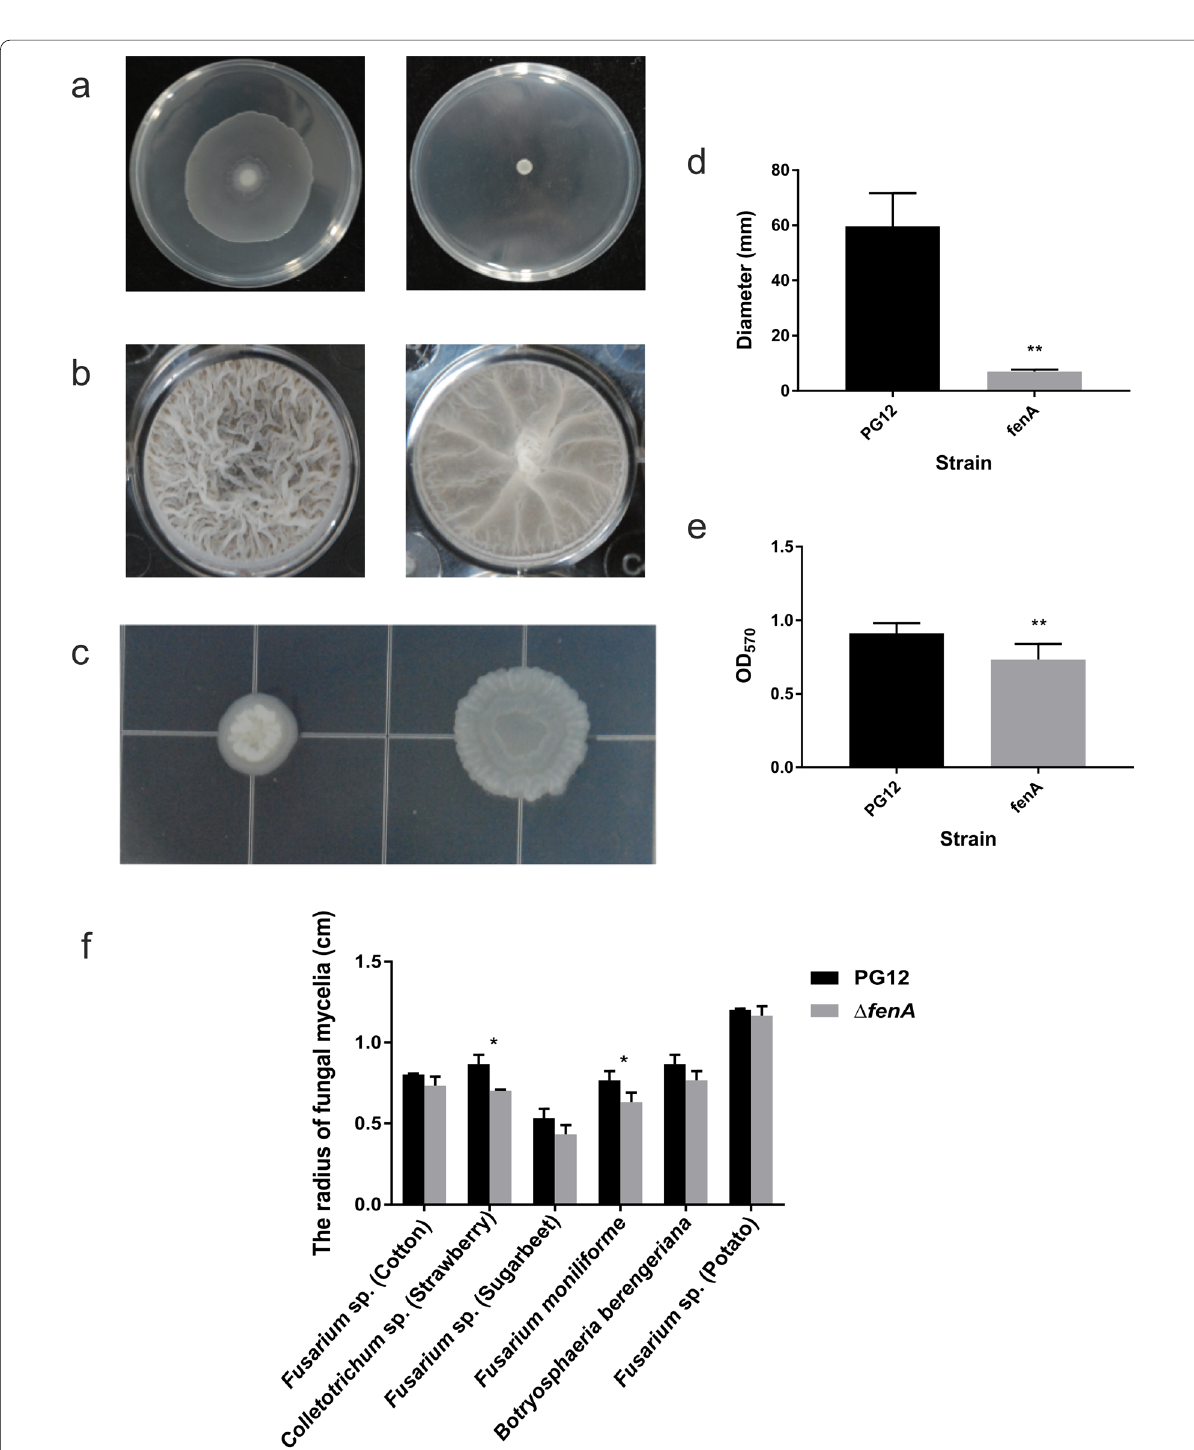
Fig. 5 Comparative analysis of the biocontrol properties of B. velezensis PG12 and ∆ fenA . a The swarming ability of PG12 and ∆ fenA . b Pellicle formation on MSgg liquid media. c Colony morphology on MSgg media. d Quantitative analysis of swarming ability. e Quantitative analysis of biofilm formation. f Measurement of the inhibition zones of PG12 and ∆ fenA. Data are an average of three replicates three independent experiments. Bars represent standard deviations. ** and * represent P < 0.01 and P < 0.05 (t-test),